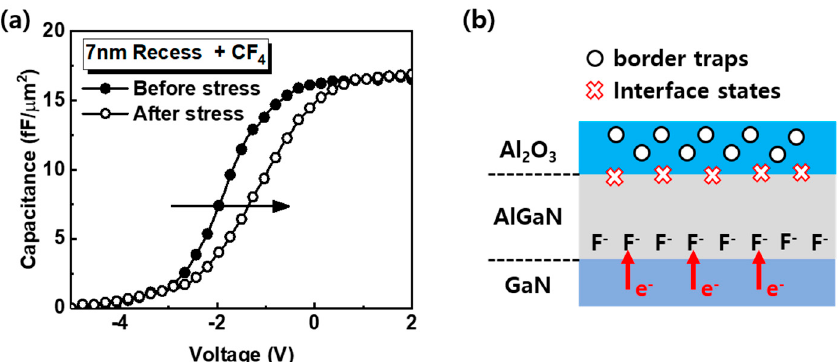
Figure 8. ( a ) The change in capacitance of the 7-nm recess + CF 4 device before and after positive gate bias stress for 1000 s. The closed circle and opened circle indicate the capacitance before and after stress, respectively. ( b ) Schematic representation of the model used to explain the V T shift of the 7-nm recess + CF 4 device. The black circle and red X represent the border traps and interface states, respectively.